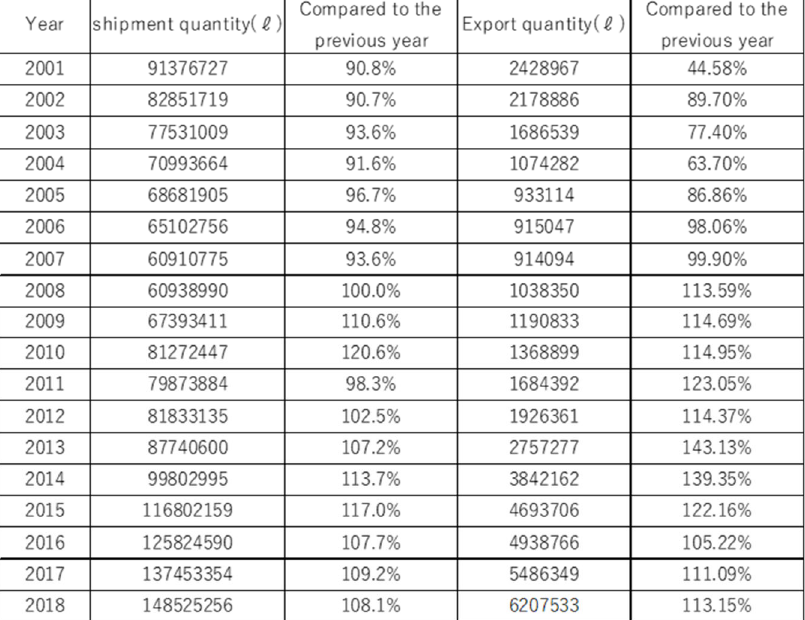
Table 1. Shipment volume/export volume of whisky in Japan